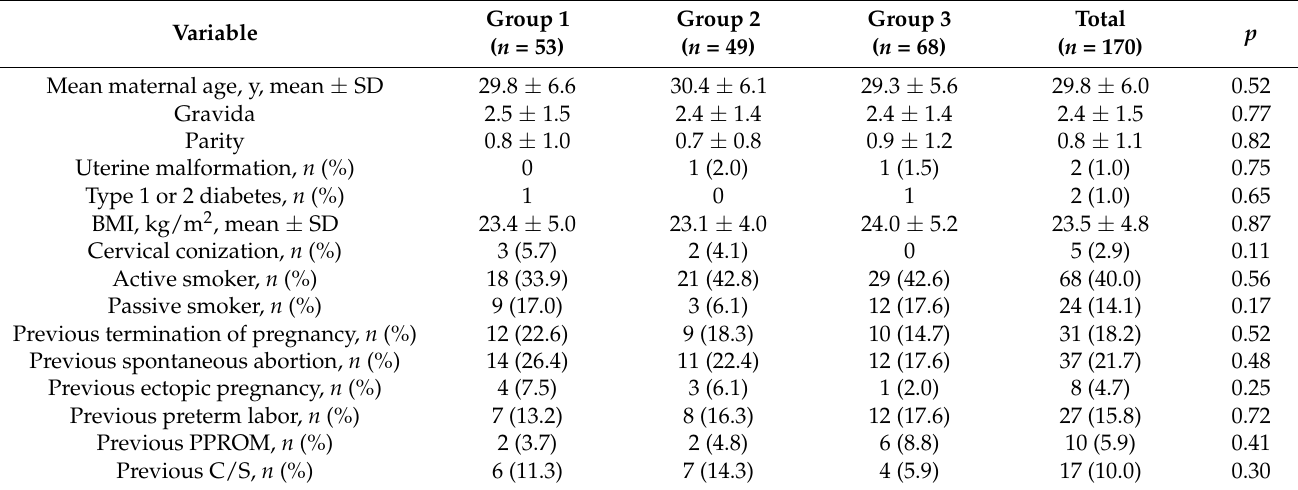
Figure 1. Flowchart.(n: number of subject) Table 1. Maternal characteristics and past obstetrical